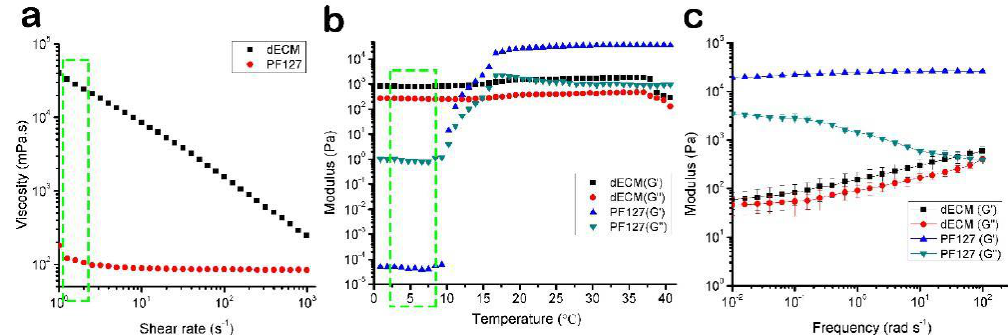
Figure 2. ( a ) Rheological properties of the dECM and PF127 viscosity at 4 °C. ( b ) Gelation kinetics from 1 °C to 40 °C (initial temperature 1 °C, increment of 1 °C min − 1 , reaching up to 40 °C.). ( c ) Dynamic modulus with varying frequency at 37 °C. All experiments were performed in triplicate. Error bars represent the SD.